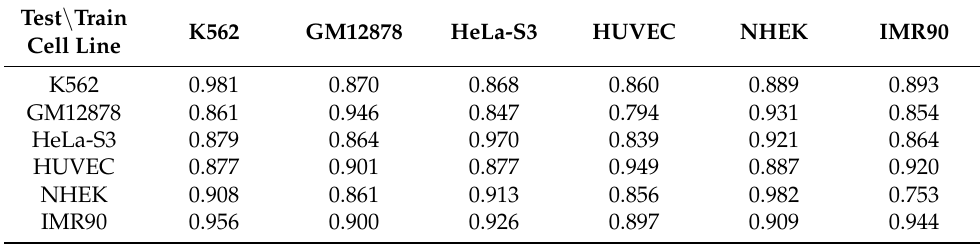
Table 4. AUPR value in